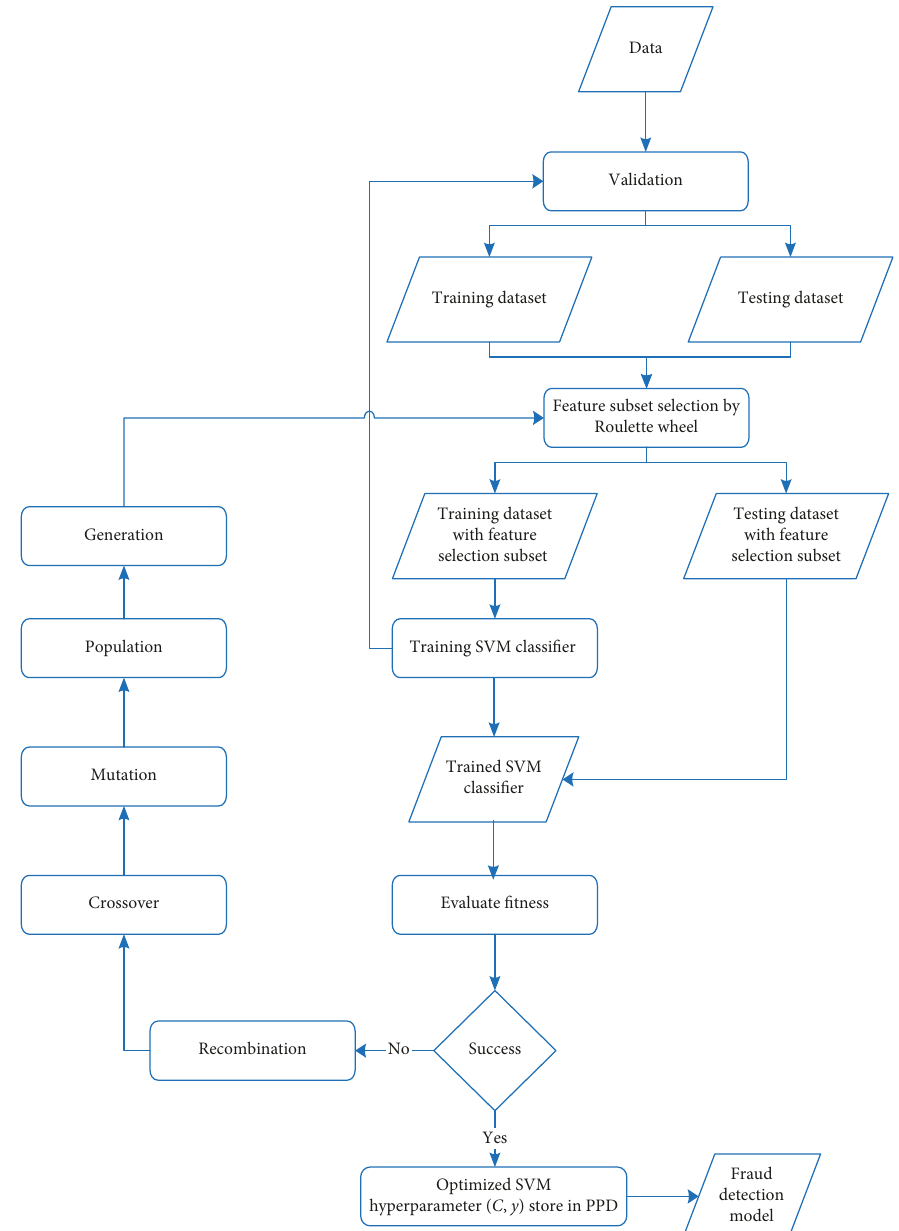
Figure 5: Flow chart for design and development of the genetic support vector